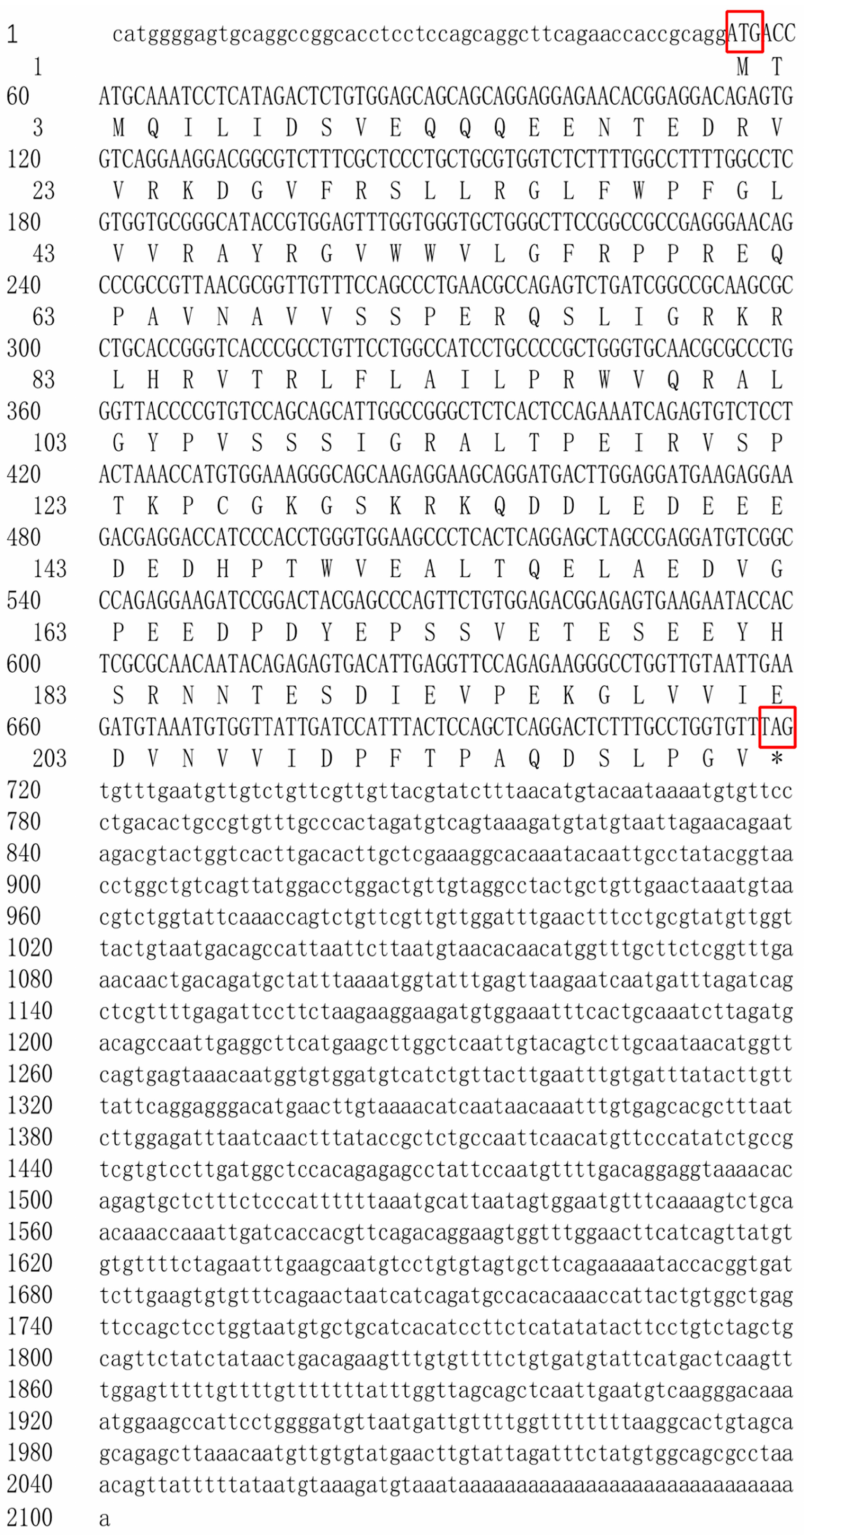
Figure 1. Full-length cDNA sequence and amino acid sequence of org gene. The ORF of org cDNA encoded 221 amino acids. The amino acid sequence is in uppercase letters. The red box represents the start codon and stop codon of org , and the stop codon is indicated by an asterisk